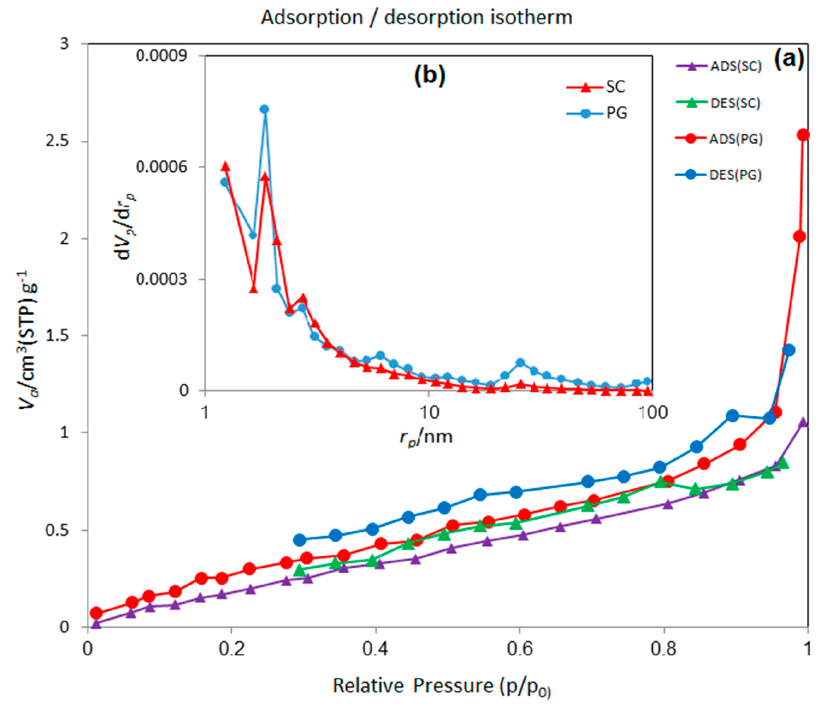
Figure 1. ( a ) Isotherms of N2 adsorption–desorption for SC and PG and ( b ) distribution of pore